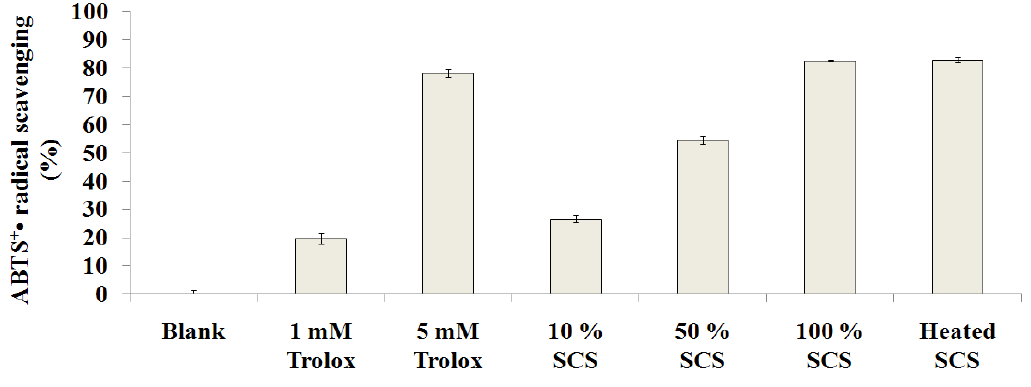
Figure 2. ABTS + • radical scavenging activities of standard samples and Lr-SCS